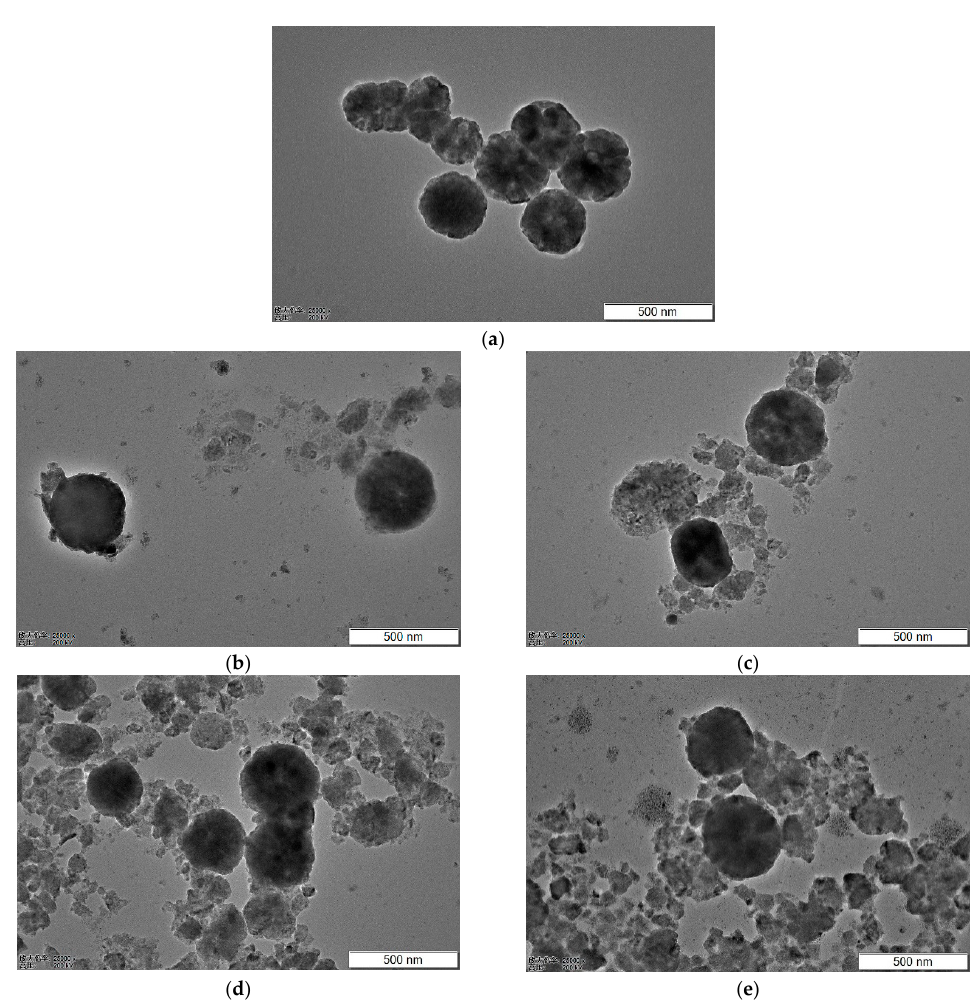
ff erent ball-milling times. ( a ) Ball milling for 0 h; ( b ) Ball milling Figure 3. TEM images of Fe 3 O 4 at different ball-milling times. Figure 3. TEM images of Fe 3 O 4 at di for 0.5 h; ( c ) Ball milling for 1 h; ( d ) Ball milling for 1.5 h; ( e ) Ball milling for 2.0